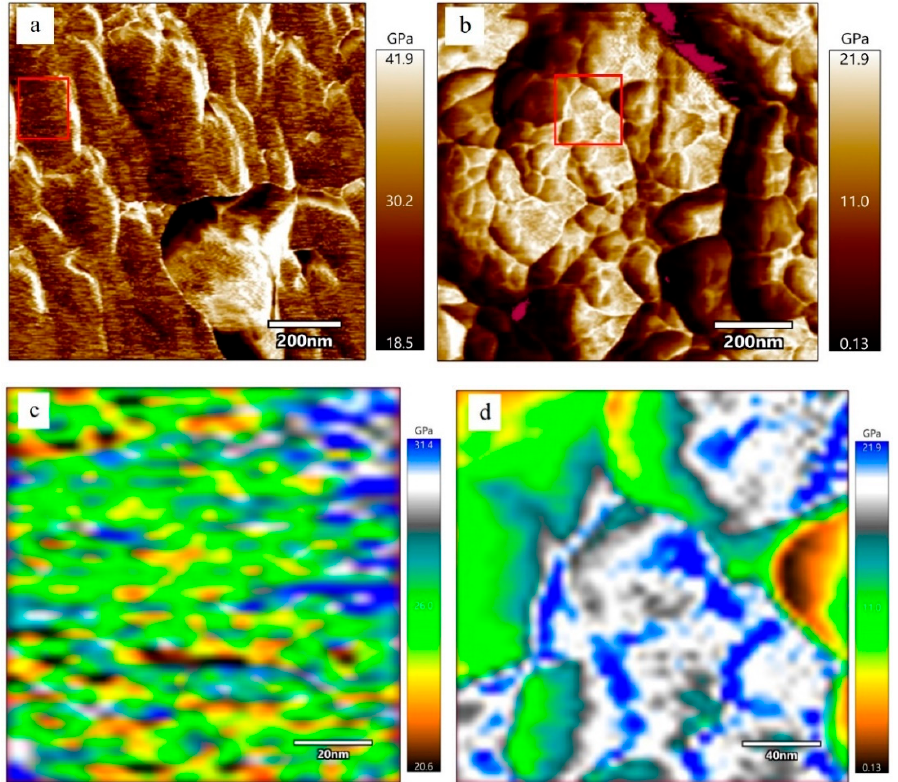
Figure 5. Elastic modulus spatial distribution of stacking units of pure C-S-H and PDMS-modified C-S-H at nanoscale: ( a ) and ( c ) pure C-S-H; ( b ) and ( d ) PDMCSH50.